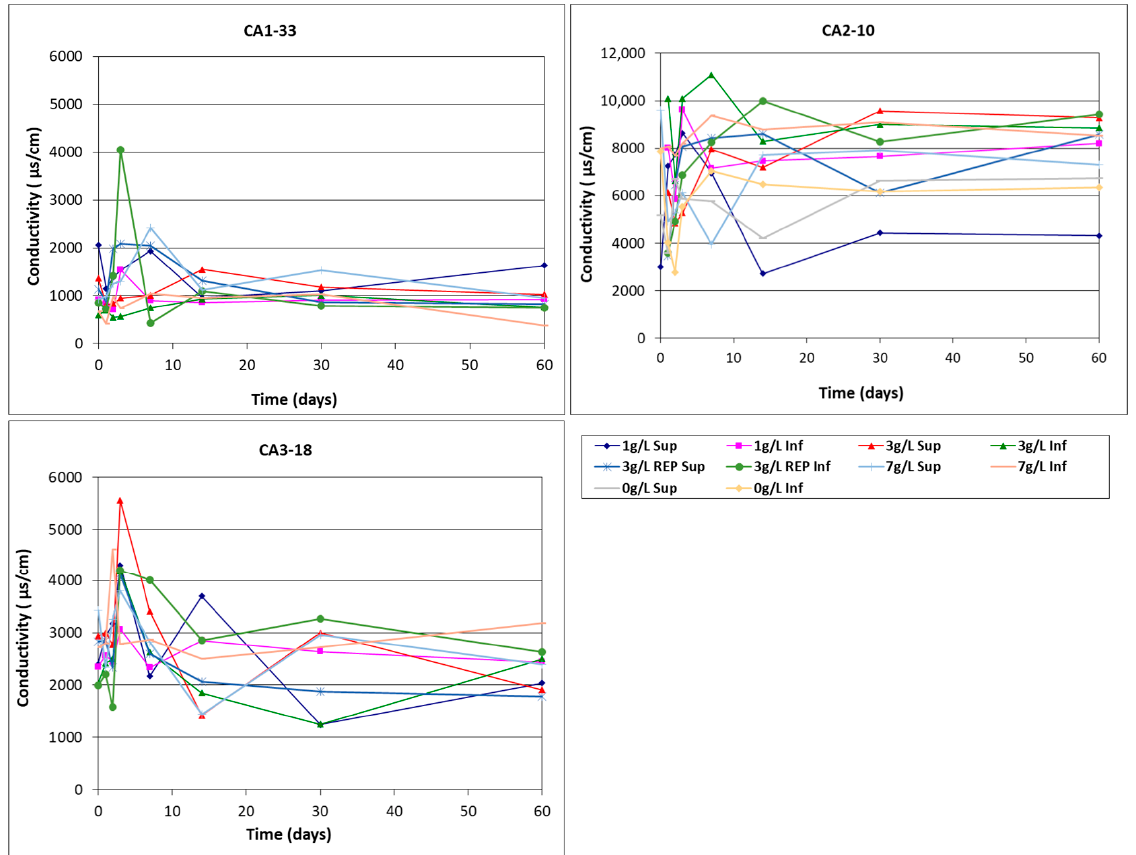
Figure 5. Variation of conductivity over the test period, at different concentrations of the nZVI suspension (blank ‐ 0 g/L, 1 g/L, 3 g/L, and 7 g/L).